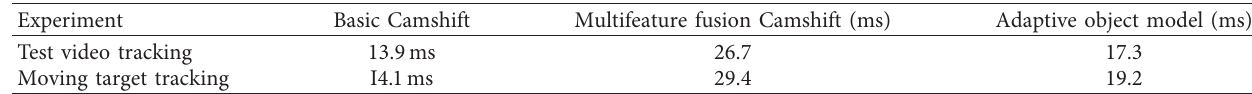
Figure 9: Results of the brightness transfer function for basketball tracking. Table 3: Single-frame tracking operation